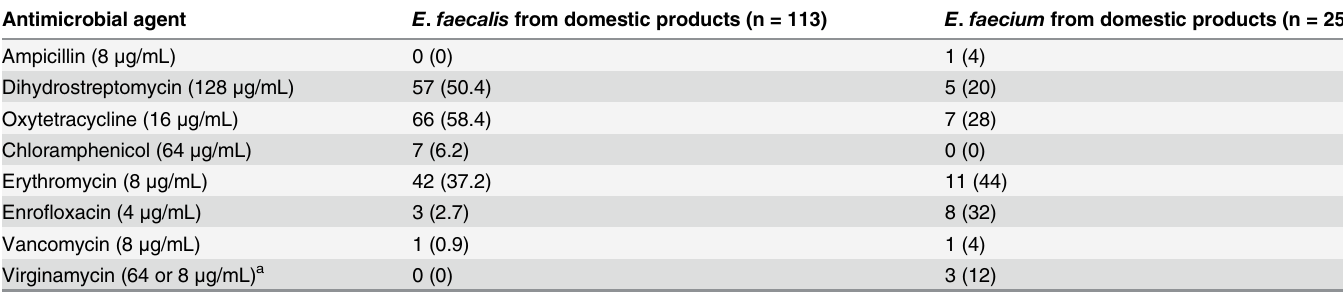
Prevalence of resistance to each tested antimicrobial in E . faecalis and E . faecium isolated from retail poultry products collected in 5 major Japanese cities between July and August 2012.